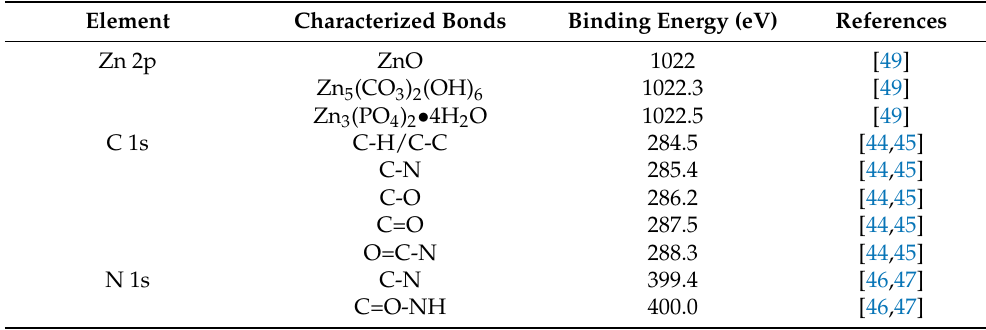
Table 1. Binding energy and corresponding compounds in the XPS spectra of Zn–0.4Li surfaces after immersion for 7